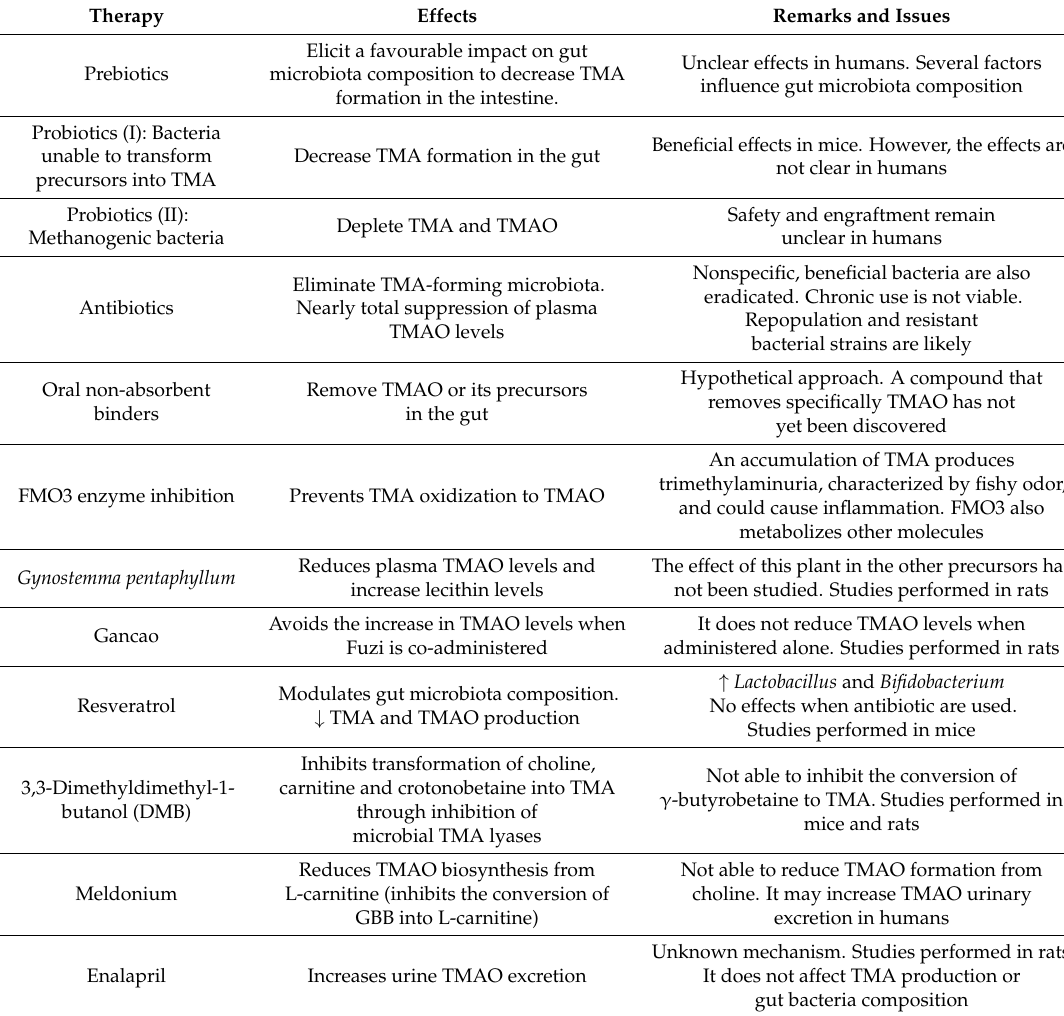
Table 5. Proposed therapeutic strategies targeting TMA